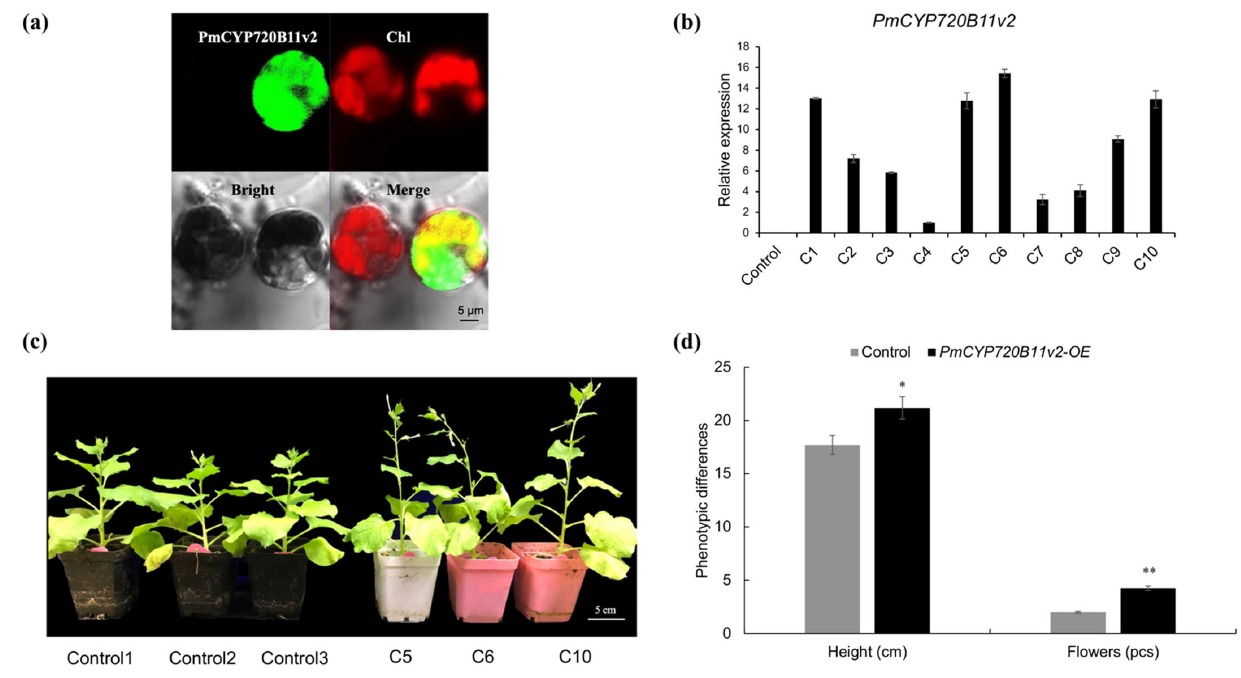
Figure 4. Overexpression of PmCYP720B11v2 enhanced diterpene production and boosted plant growth and development of transgenic tobacco. ( a ) Subcellular localization of PmCYP720B11v2. ( b ) Relative expression of PmCYP720B11v2 in 10 independent transgenic lines. ( c ) Different phenotypes in positive transgenic tobacco seedlings overexpressing PmCYP720B11v2 ; bar, 5 cm ( d ) Analysis of height and flowers in transgenic tobacco overexpressing PmCYP720B11v2. Confidence levels were